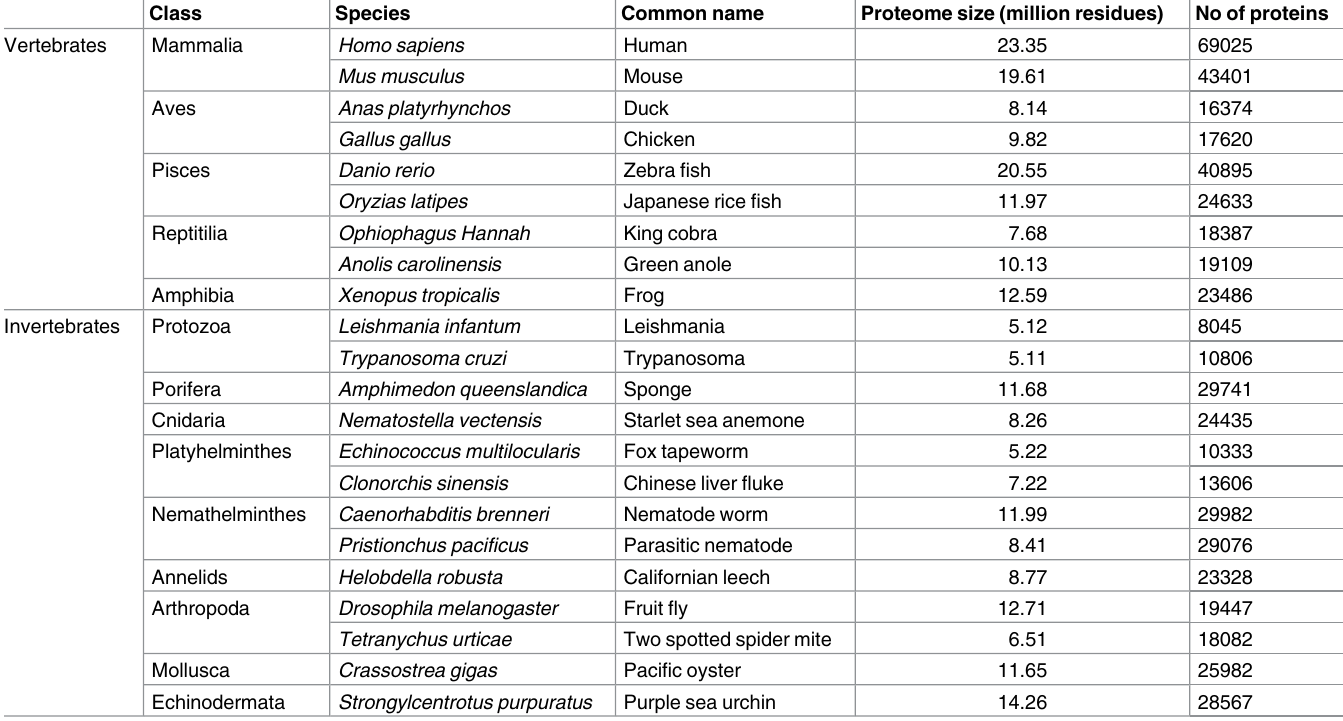
Table 1. Invertebrateand vertebratespecies under